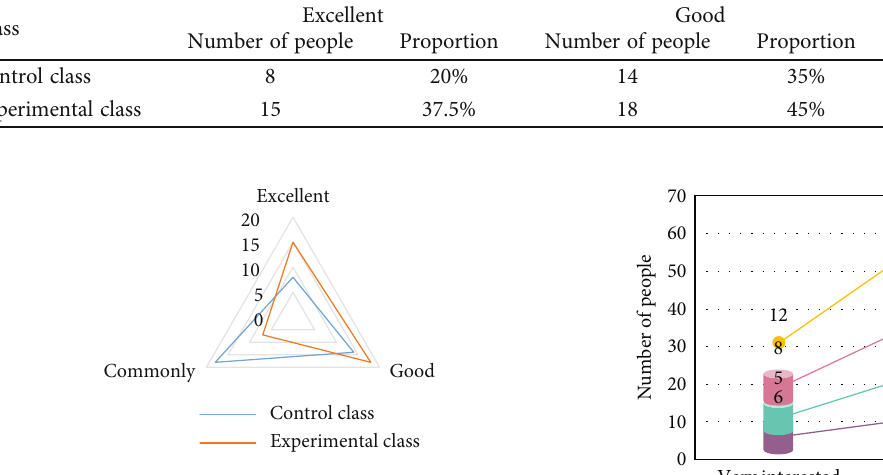
Figure 3: Number of students in each grade of two classes.